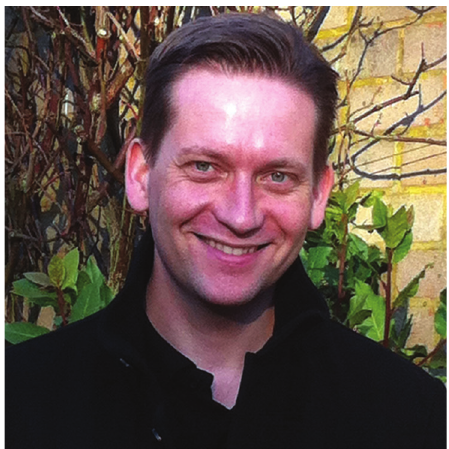
Figure 5. David Hall. The photograph was taken by his eldest daughter, Tara Hall.